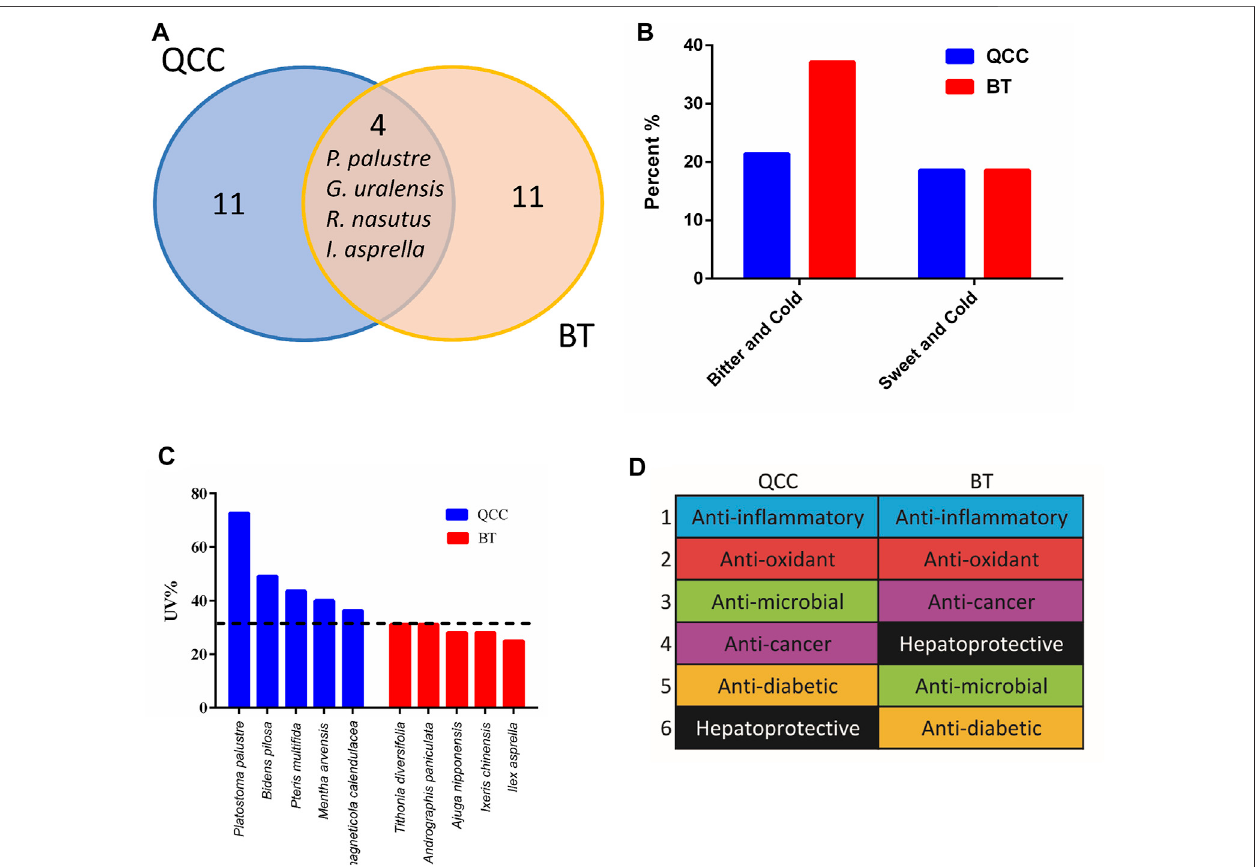
FIGURE 4 | Comparisons between Taiwanese bitter tea and green herb tea. (A) Venn diagram of the top 15 most commonly used plant materials in bitter tea and greenherbtea. (B) Comparisonofthenatureand fl avoroftheplantmaterials. (C) Usevaluesofthetop fi vemostcommonlyusedplantmaterials(1 – 5indicatethetop fi ve commonly used plant materials). The horizontal dotted line indicates the highest UV ofBT. (D) Modern pharmacological applicationsof thetop 15most commonly used plant materials. QCC, qing-cao-cha (green herb tea); BT, bitter